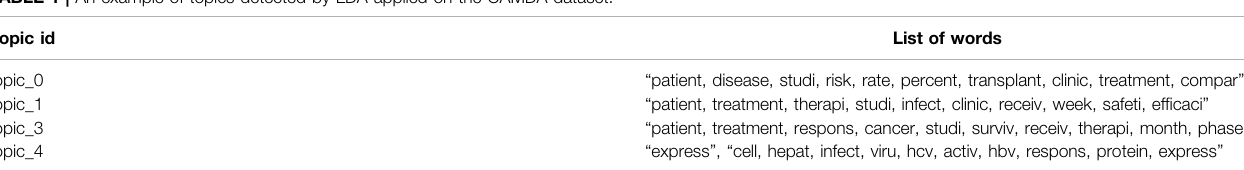
TABLE 1 | An example of topics detected by LDA applied on the CAMDA